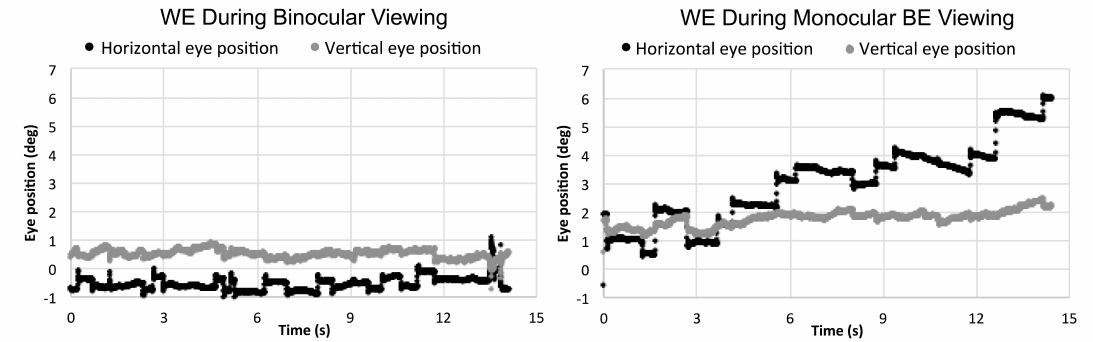
Figure 3. Horizontal and vertical eye position of the WE (worse eye) during binocular and monocular WE viewing for the 15s fixation